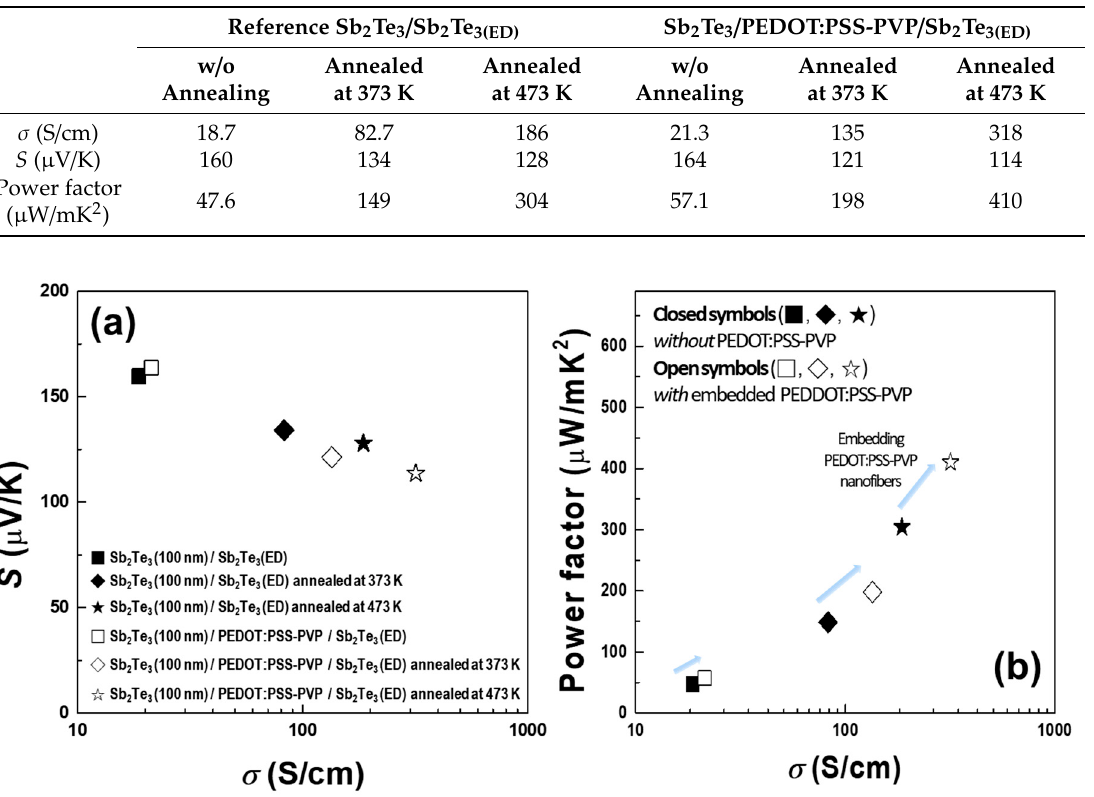
Figure 5. Comparison of the ( a ) Seebeck coefficients S and ( b ) power factors for reference Sb 2 Te 3 / Sb 2 Te 3(ED) and Sb 2 Te 3 / PEDOT:PSS-PVP / Sb 2 Te 3(ED) composite films as functions of the electrical conductivity σ and annealing temperature.